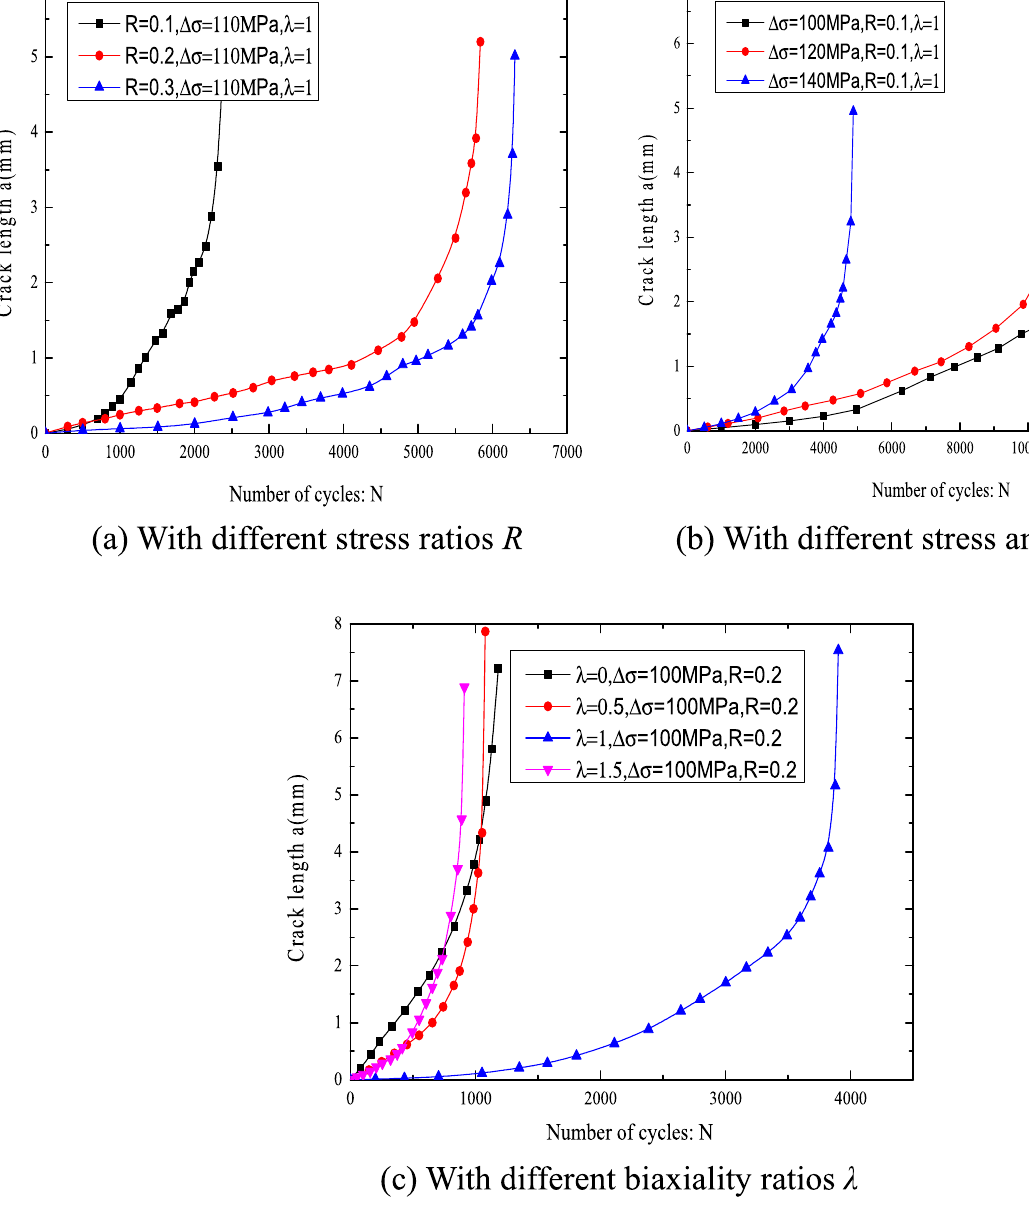
Fig. 11 a–N curves of biaxial low-cycle fatigue test for different biaxiality